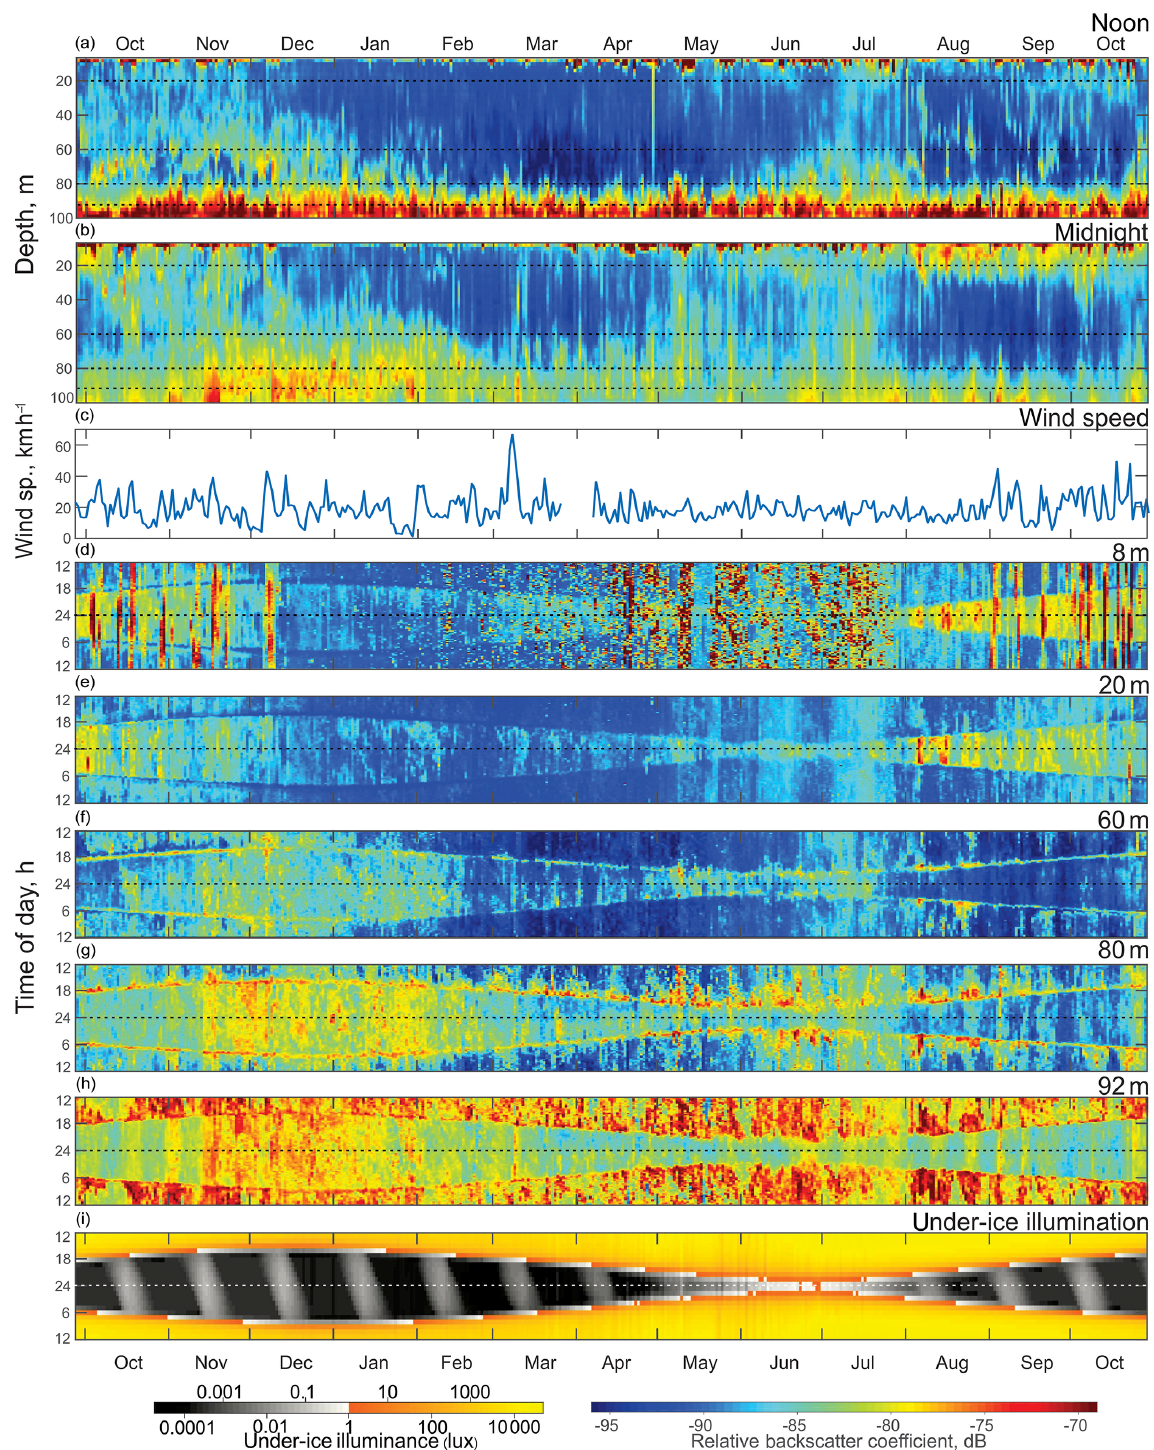
Figure 3. Time series (October 2016 to October 2017) of the (a) ADCP acoustic volume backscatter coefficient at noon and (b) at midnight, (c) daily mean wind speed measured at Churchill airport (YYQ), and (d) – (i) actograms of ADCP acoustic backscatter at five depth levels: (d) 8m, (e) 20m, (f) 60m, (g) 80m, and (h) 92m, as well as (i) modeled under-ice illuminance. Dashed horizontal lines represent astronom- ical midnight. The diurnal signal is presented at the vertical axis, while the long-term changes in diurnal behavior are presented along the horizontal